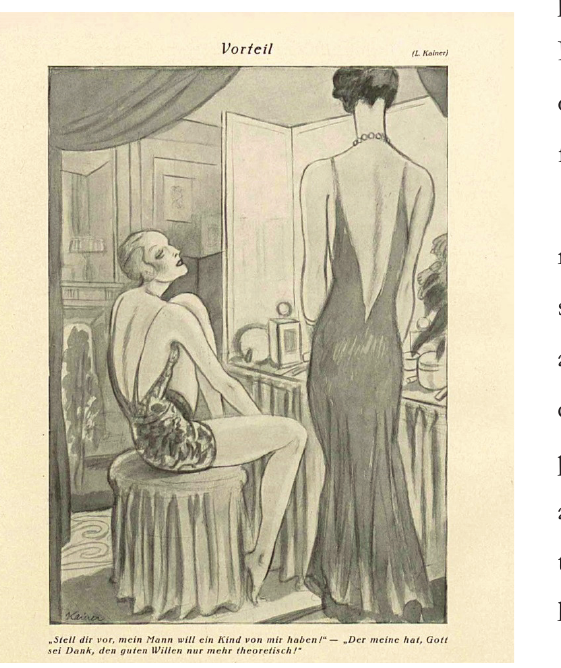
Figure 10. Simplicissimus , 5 May 1930, p. 70. Image courtesy of Herzogin Anna Amalia Bibliothek